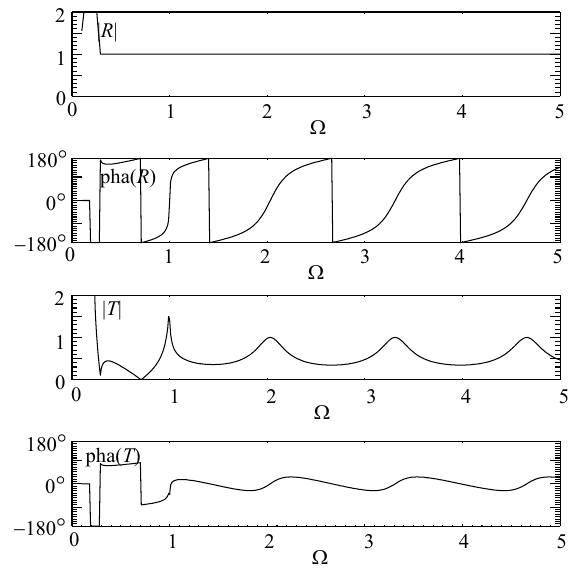
Fig. 2. Amplitude and phase of the reflection and transmis- sion coefficients when excitation of the resonance is